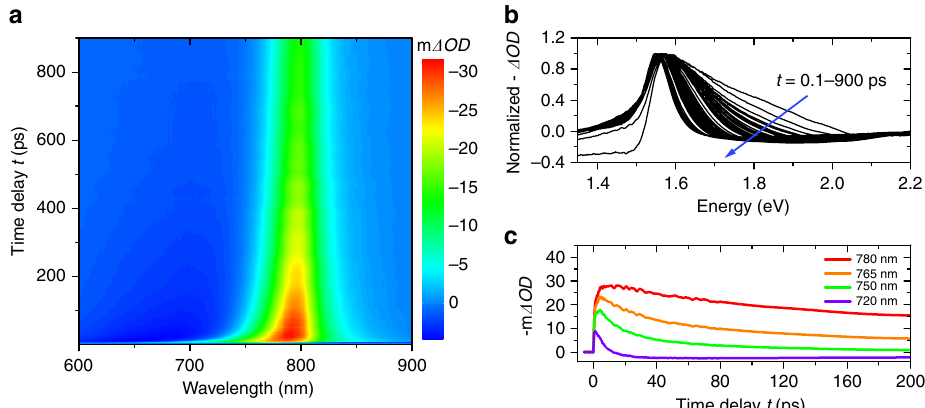
Figure 1 | Transient absorption spectra of the FAPbI 3 sample. ( a ) 3D TA spectrum pumped at 400nm with an initial carrier concentration N 0 ¼ 4.84 (cid:3) 10 18 cm (cid:2) 3 . The initial broadening of the bleaching signal extending above the apparent band gap energy indicates the temporary presence of hot carriers. ( b ) Normalized negative TA spectra ( (cid:2) D OD ) at different pump-probe time delays t from 0.1 to about 900ps. ( c ) Decay of the bleaching signal given as minus milli D OD ( (cid:2) m D OD ) at different wavelengths showing carrier relaxation